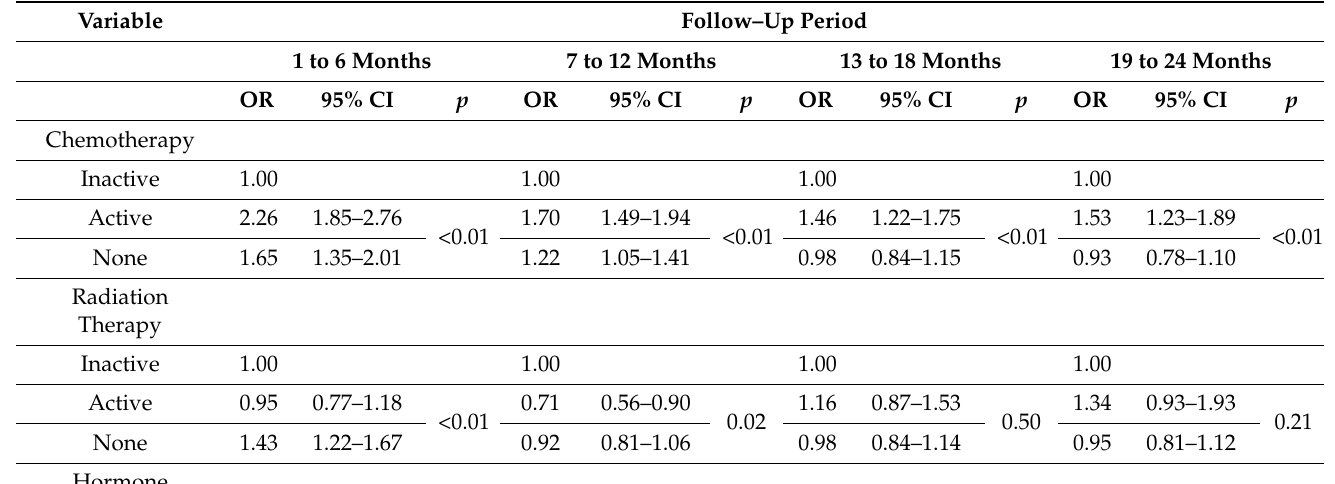
Table 3. Multivariable logistic regression model describing factors associated with ED visits stratified by follow-up time